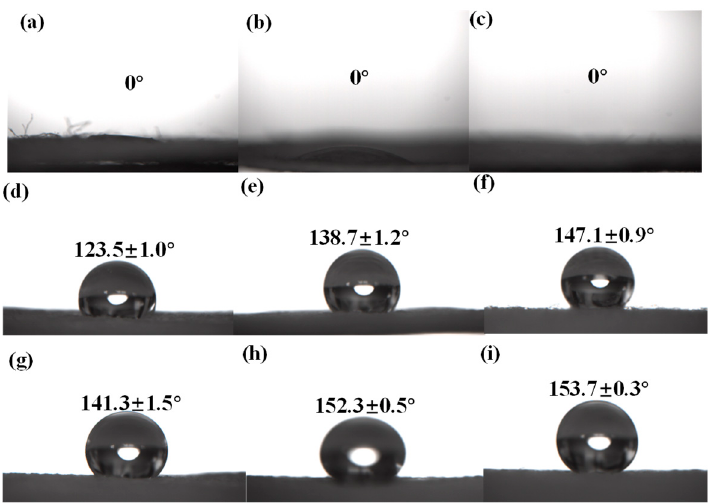
Figure 9. Photographic images of water droplet on the different cotton samples surface. Pristine cotton ( a ), CS/APP cotton ( b ), 0.15 g TiO 2 amounts of TiO 2 -SiO 2 -HMDS cotton ( c ), different TiO 2 amounts (( d ). 0.15 g, ( e ). 0.45 g, ( f ). 0.75 g) of CH/APP@TiO 2 -SiO 2 -HMDS cotton, different HMDS amounts (( g ). 3 mL, ( h ). 6 mL, ( i ). 7.5 mL) of CH/APP@TiO 2 -SiO 2 -HMDS cotton.